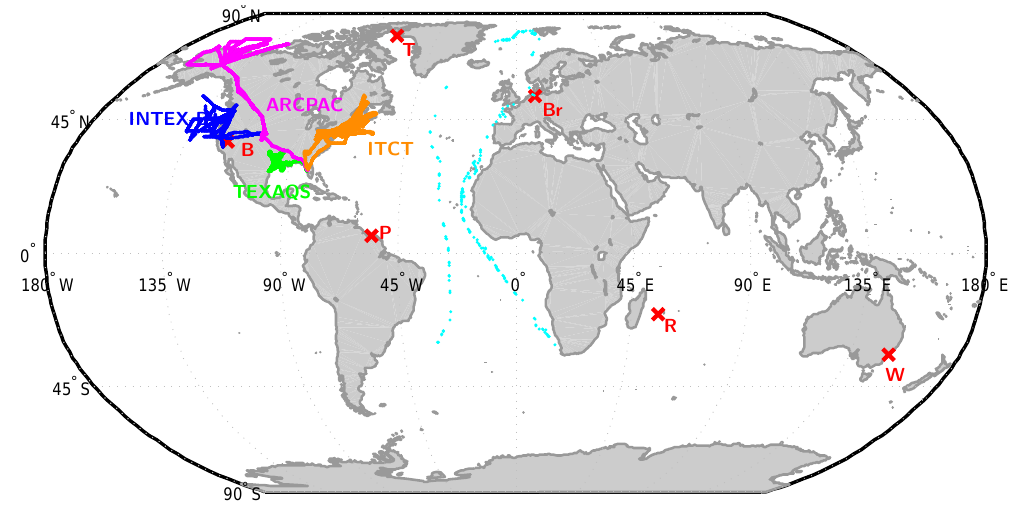
Fig. 2. Locations of the measurement sites used in this study. Red crosses: FTS ground stations (B: Barcroft, Br: Bremen, P: Paramaribo, R: La R´eunion, T: Thule, W: Wollongong). Cyan dots: ship cruises. Blue, Magenta, Yellow and Green dots: aircraft missions flight